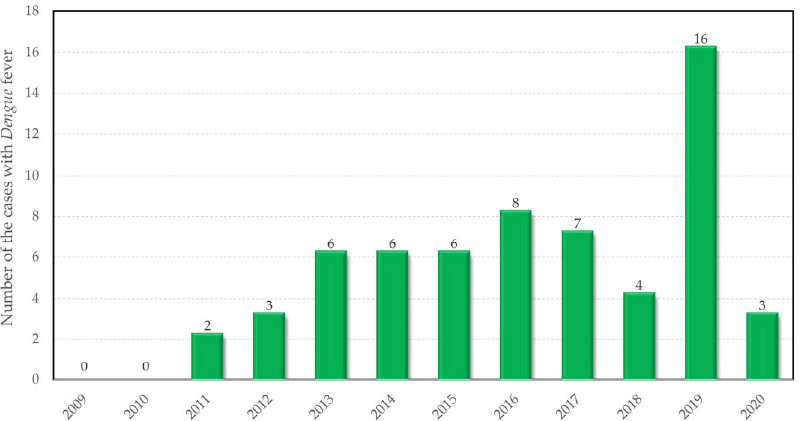
Figure 2. The number of imported cases of dengue fever registered in Romania between 2009 and